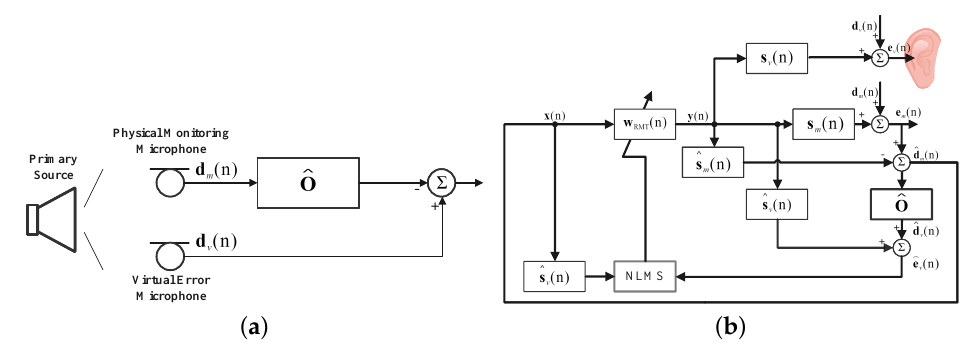
Figure 4. Block diagram of the remote microphone method (RMM). ( a ) Tuning stage. ( b ) Con- trol